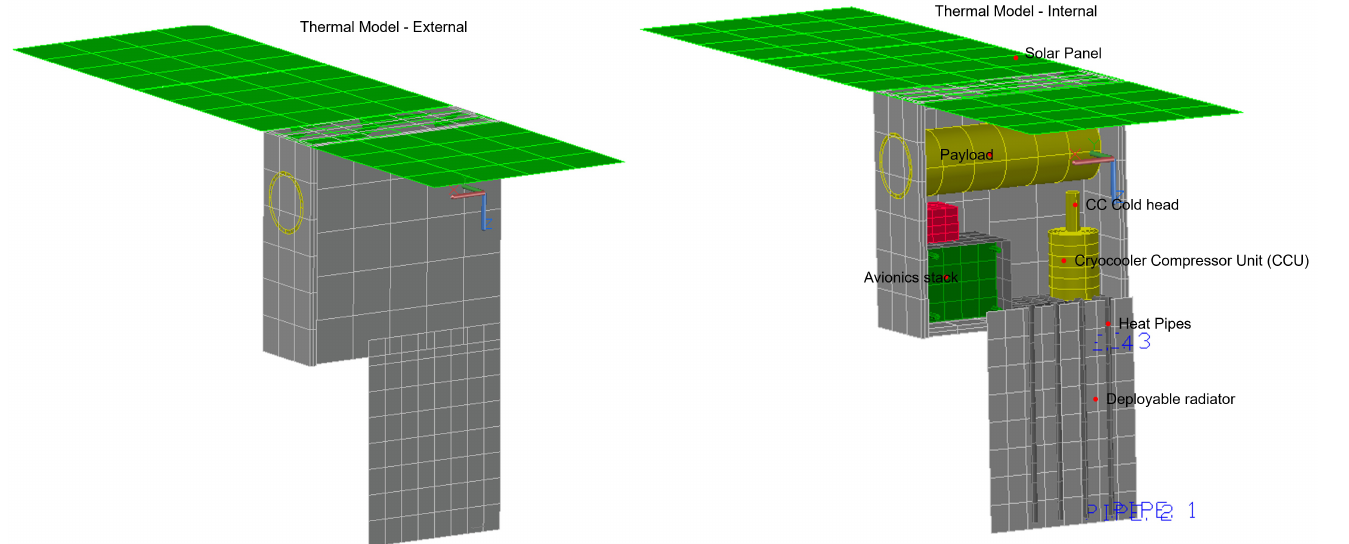
Figure 18. 6U Satellite deployable radiator with heat pipes—Thermal model.